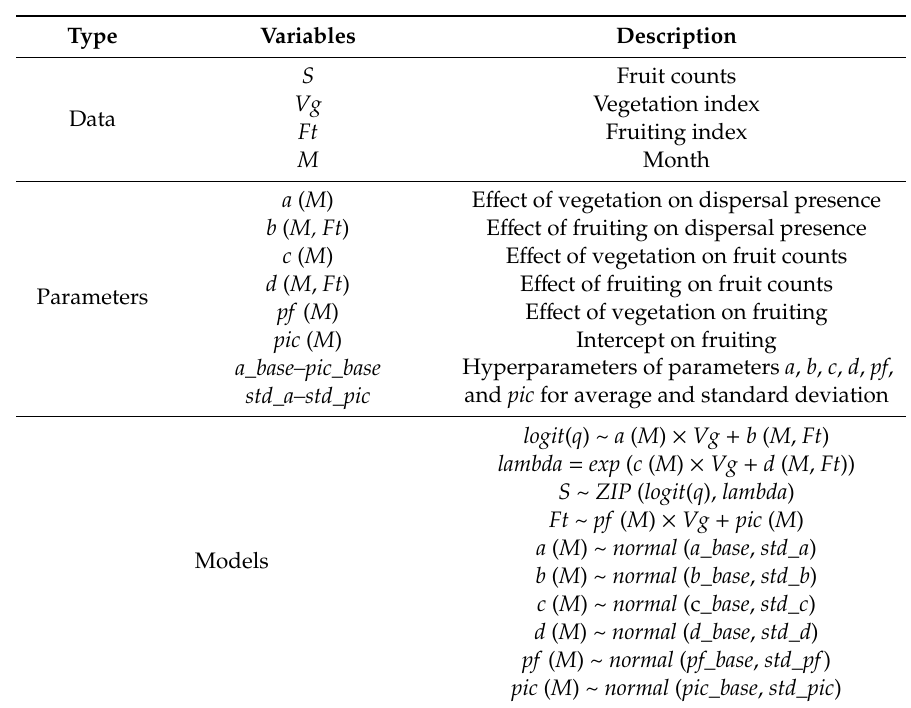
Table 2. Formula of hierarchical Bayesian zero-inflated Poisson model with each variable and its